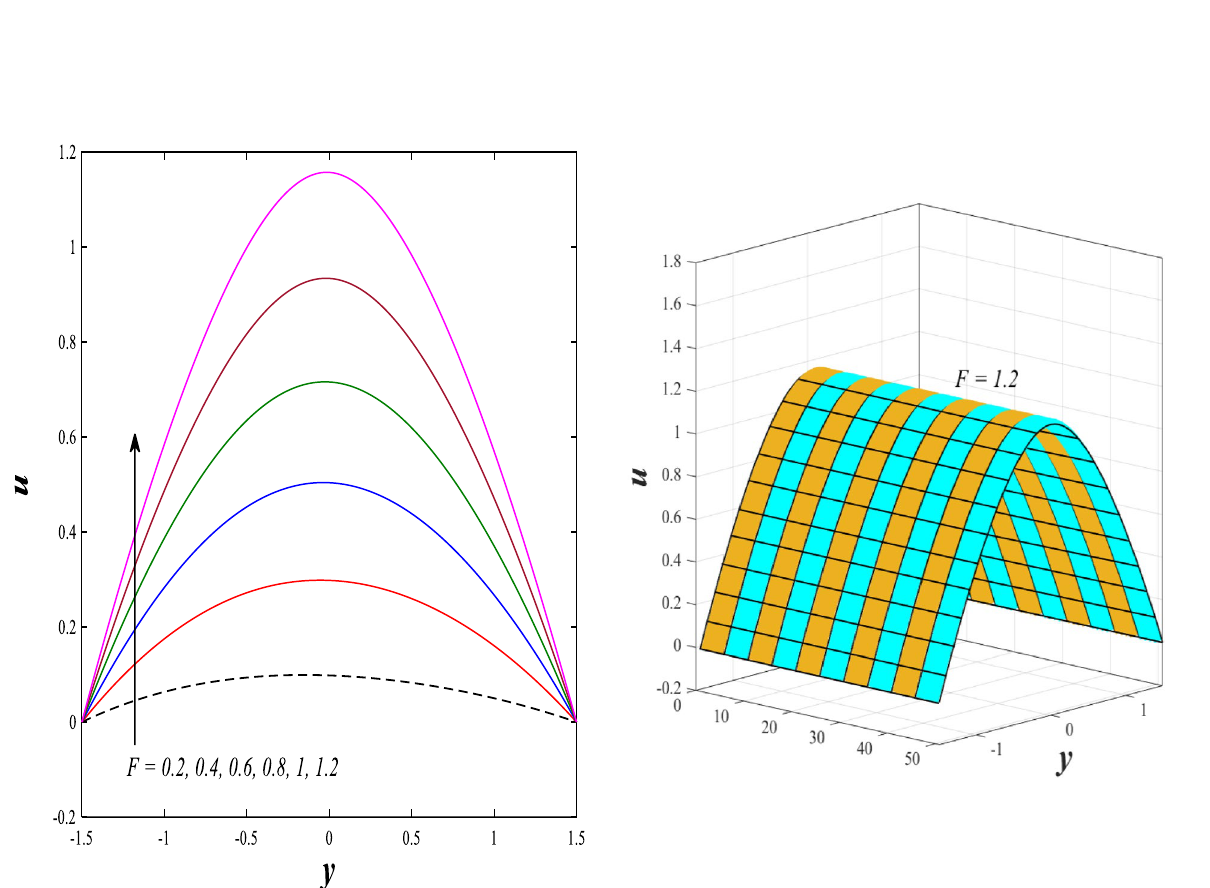
Figure 8. Effect of mean flow rate F on the axial velocity distribution 2D and